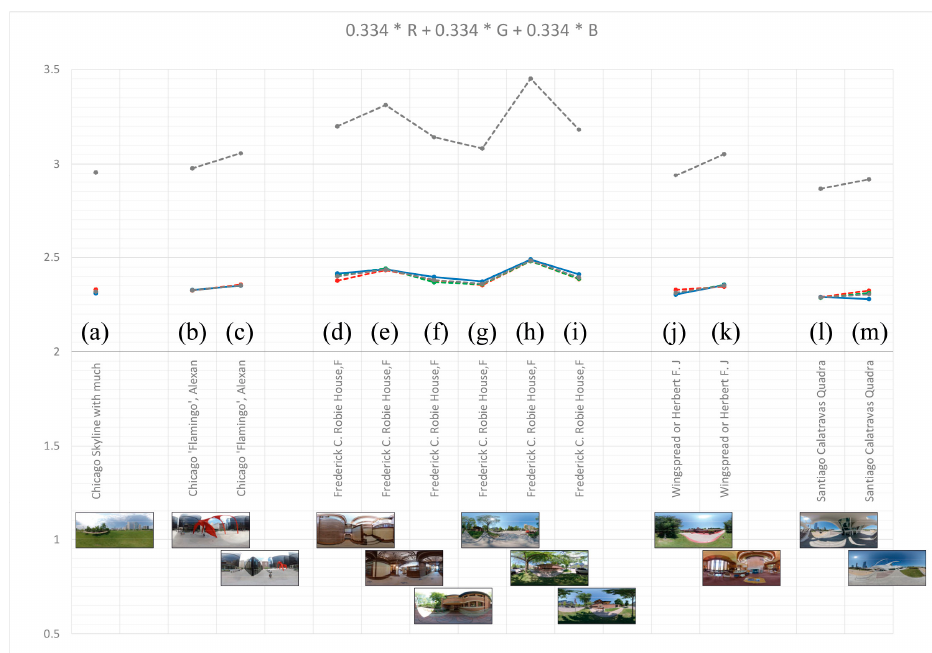
Figure 14. Measurement method “Color DBX M × N ( m × m ) (shifting boxes)” with the standard grayscale conversion (see Formula (12)) applied to di ff erent spherical photographs.